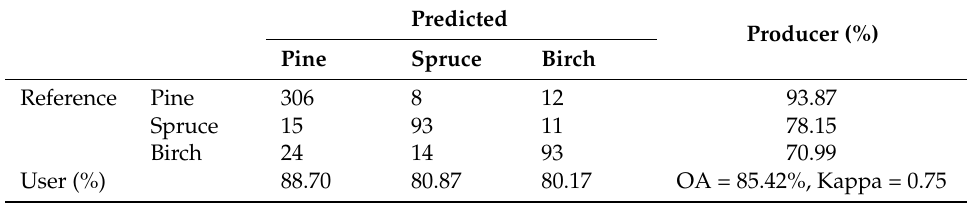
Table 5. Confusion matrix and accuracy evaluation of classification with 15 selected single-channel intensity features and test data.